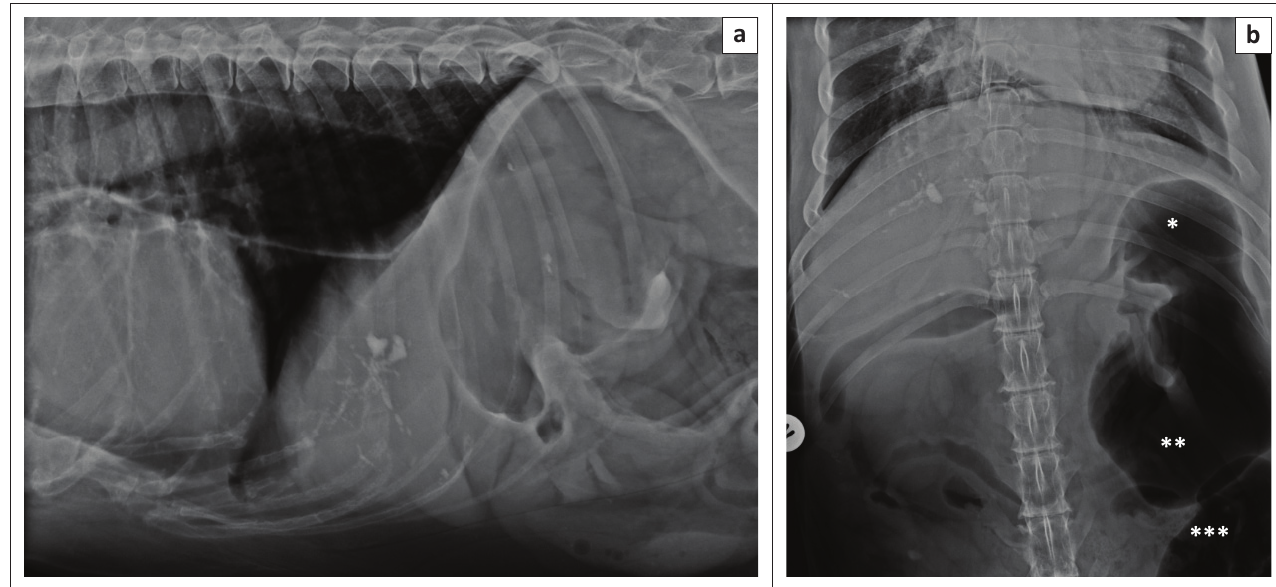
FIGURE 1: (a) Lateral caudal thorax and cranial abdominal radiograph and (b) ventrodorsal caudal thorax and cranial abdominal radiograph of a dog with chronic gastric volvulus. Note the air-filled caudal oesophagus, arborising mineralisation of the ventral liver and the abnormally positioned gas-filled stomach (a). The sagittally orientated gastric axis with the pylorus ( * ) cranially and fundus ( ** ) caudally is shown in (b). The caecum and ascending colon ( *** ) have been displaced to the left (b).